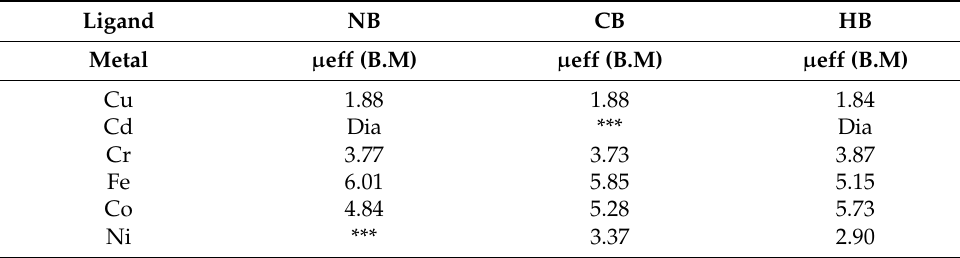
Table 1. Magnetic susceptibility (B.M., Bohr Magnetons), of NB, CB and HB complexes. Ligand NB CB HB Metal µ eff (B.M) µ eff (B.M) µ eff (B.M) Cu 1.88 Dia